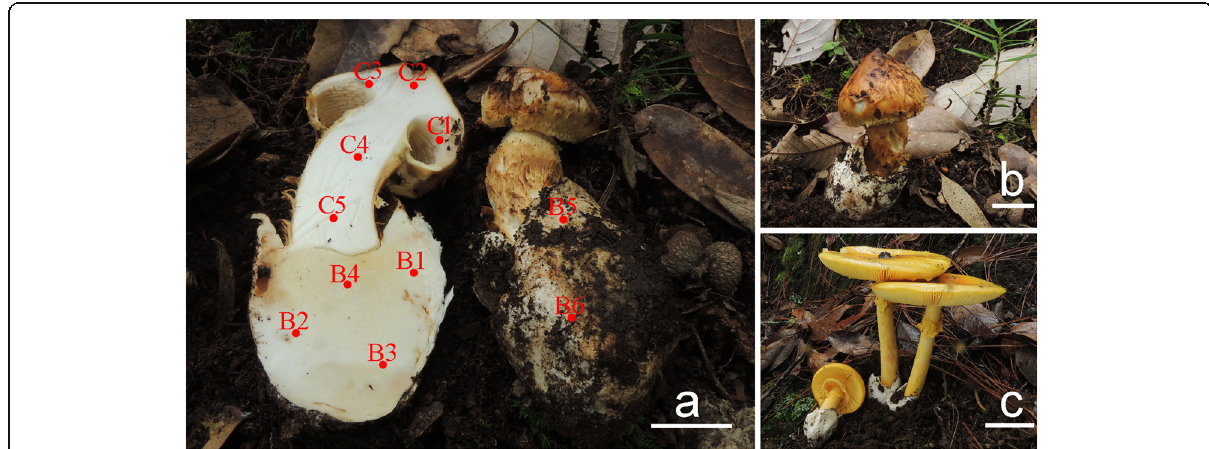
Fig. 6 a – b Basidiomes of Squamanita mira HKAS100826 (holotype) photos by Jian-Wei Liu. Bars: 20 mm. c Basidiomes of Amanita kitamagotake .